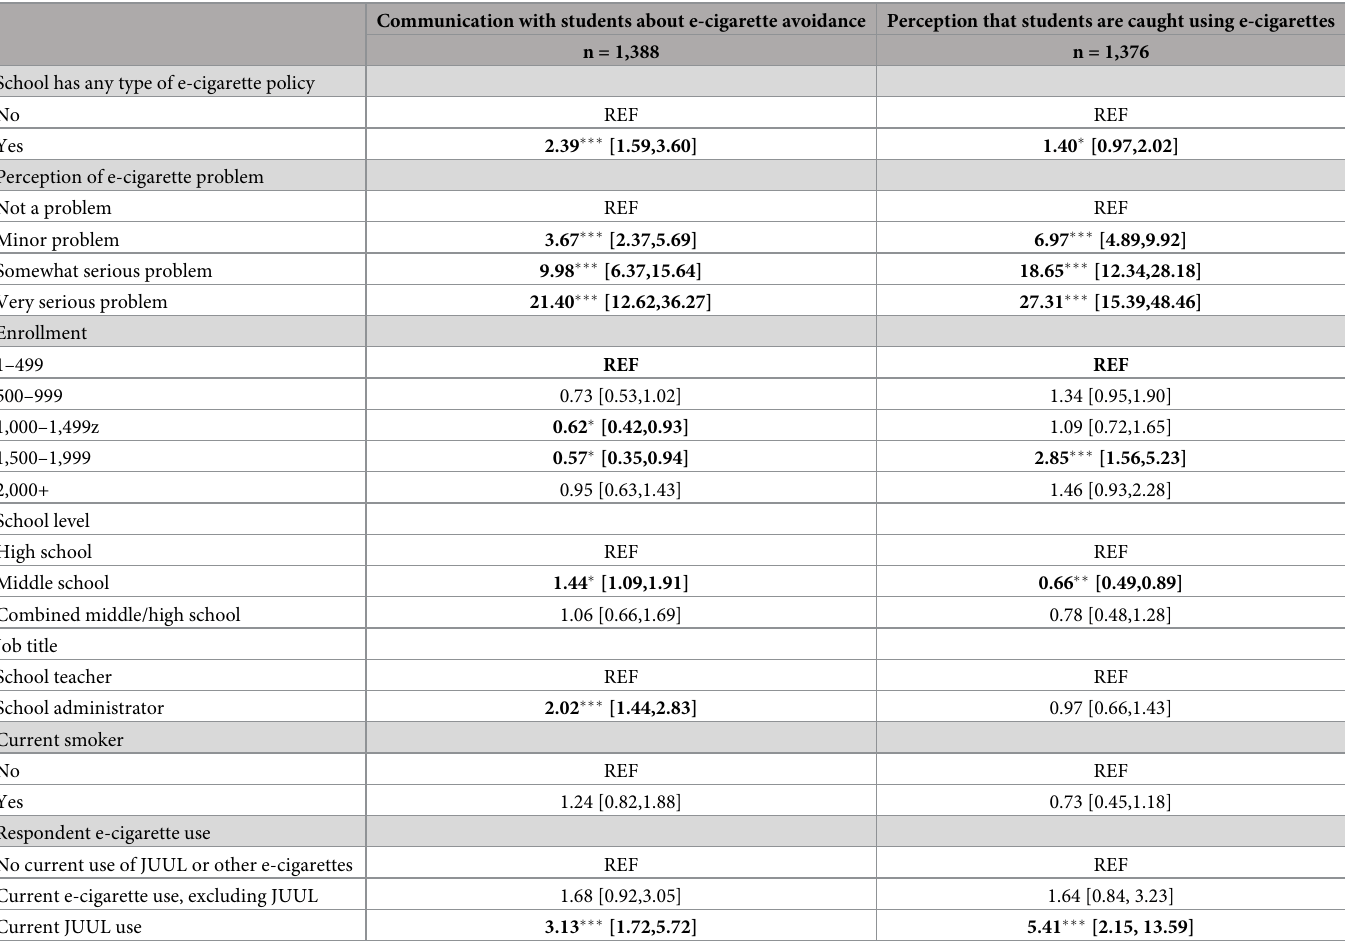
Table 3. Predictors of school personnel communication with students about e-cigarette avoidance. Communication with students about e-cigarette avoidance Perception that students are caught using e-cigarettes n =